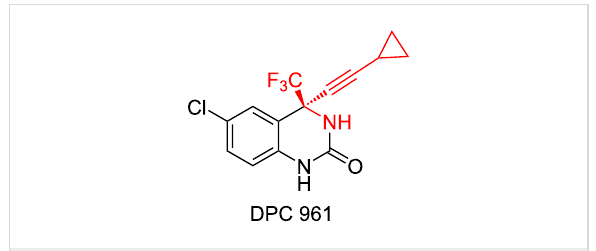
Figure 1: Anti-HIV compound containing a trifluoromethylpropargyl- amine moiety.